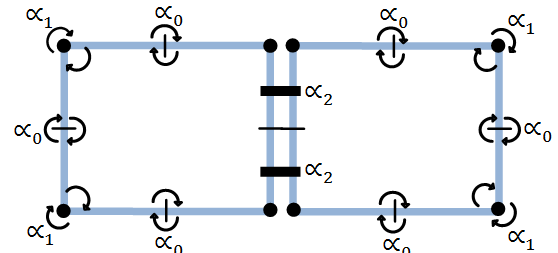
Figure 3 . Example of gathering two faces in 2D model by .